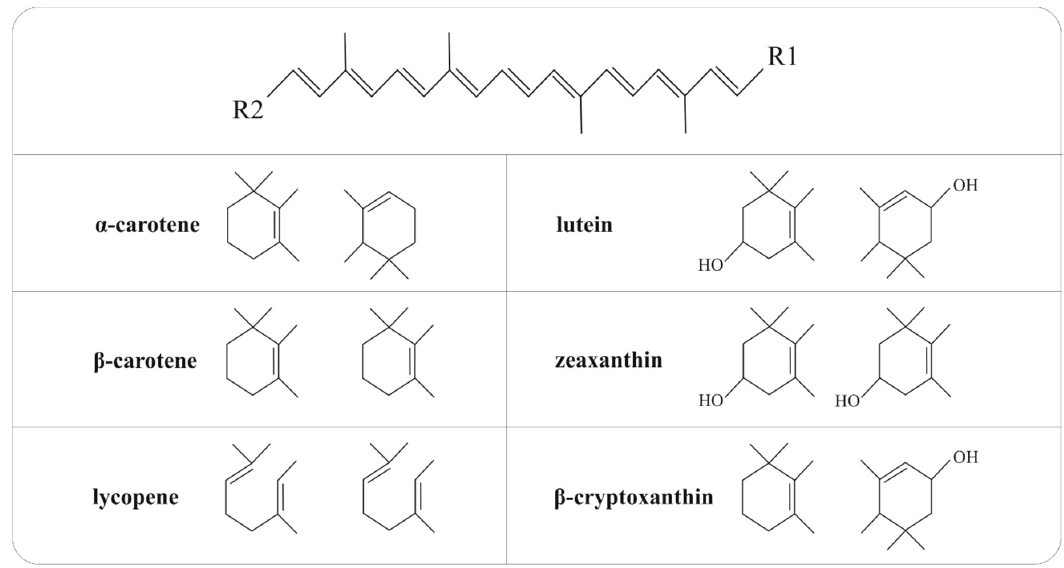
Figure 4. The chemical structure of major representatives of carotenoids. The main part of the carotenoid structure includes a central carbon chain with alternating single and double bonds and various cyclic or acyclic end groups (R1 and R2), which vary in individual carotenoids.